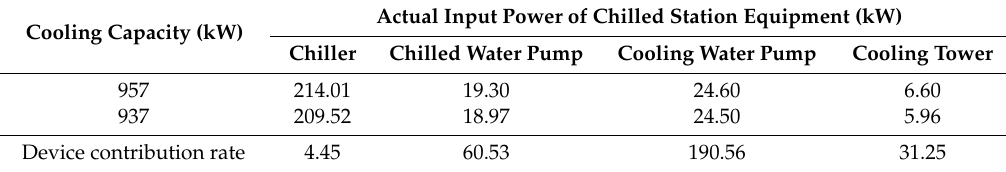
Table 6. Changing table of the cooling capacity and equipment power of the chilled